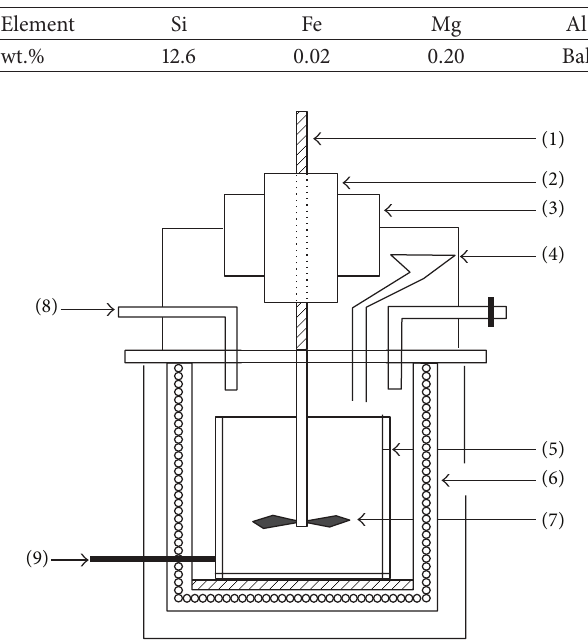
Table 1: Composition of Al-Si alloy.